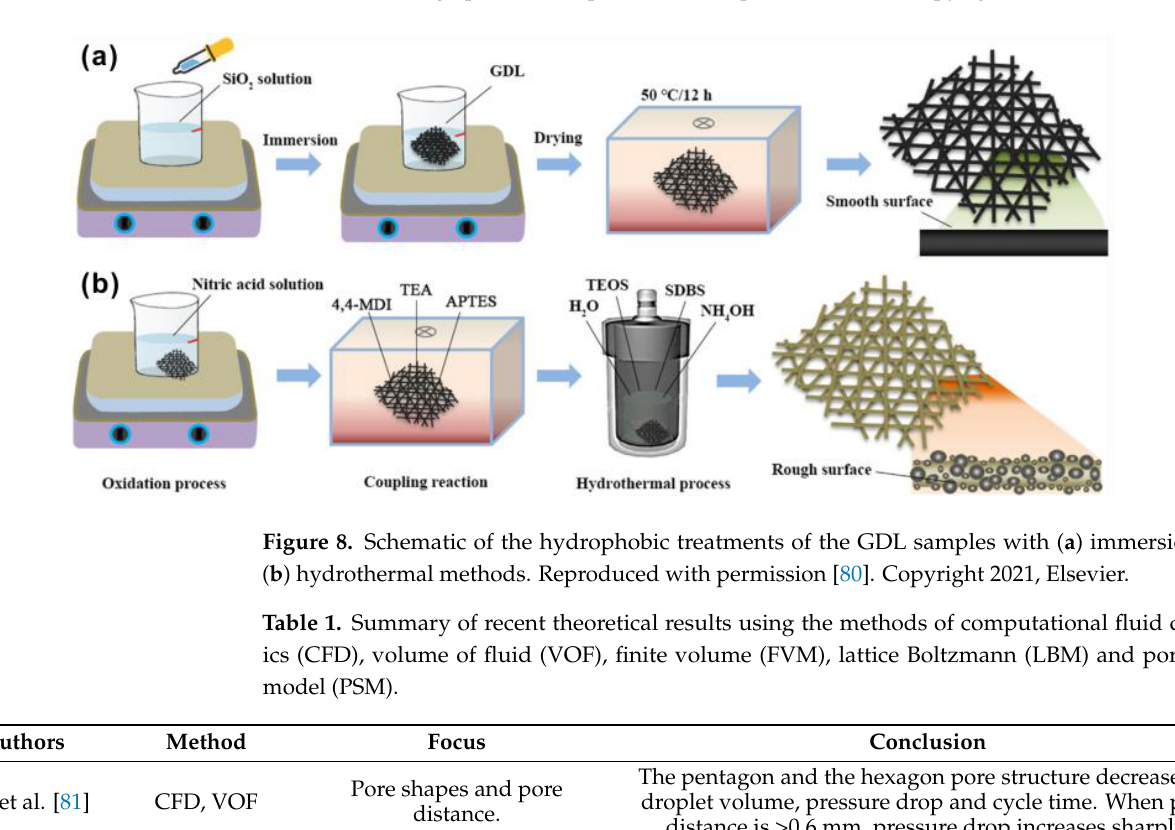
Figure 7. SEM images of the samples prepared with ( a ) the ultrasonic dispersion method, and ( b ) the direct dipping method. ( c ) Performance curves plotted with the water permeability values against water breakthrough pressure. Reproduced with permission [78]. Copyright 2022, Elsevier.